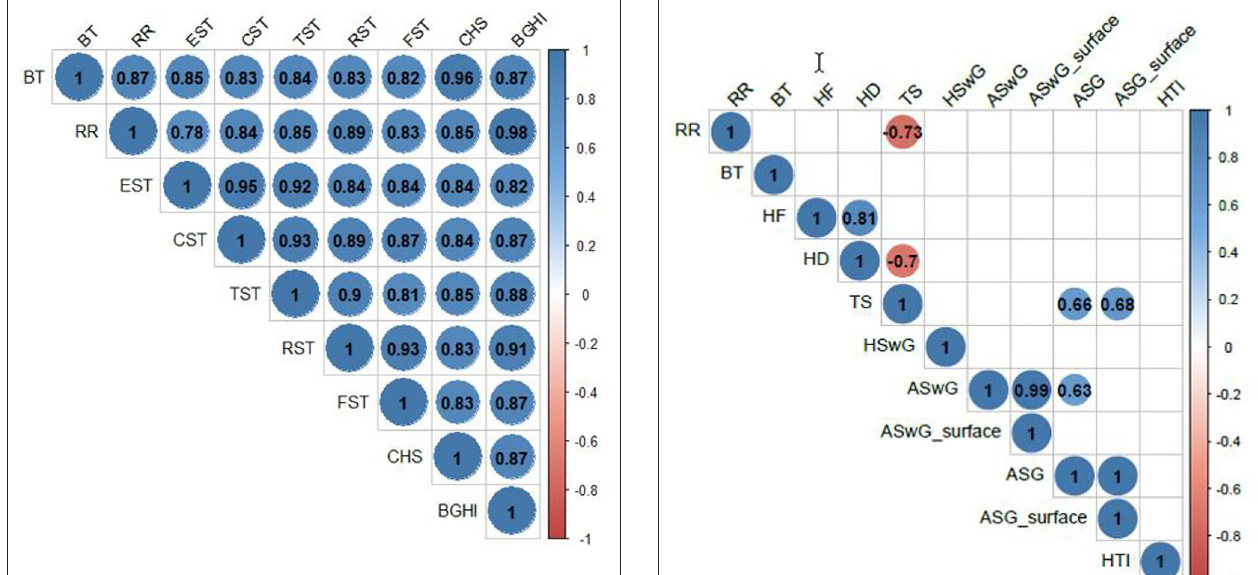
FIGURE 5 | Linear correlations between the BGHI and internal BT, RR, EST, CST, TST, RST, FST, and CHS during the HTT performed in adult female buffaloes reared in humid tropical climate. FIGURE 6 | Linear correlations among the HTI, internal BT, and RR and the